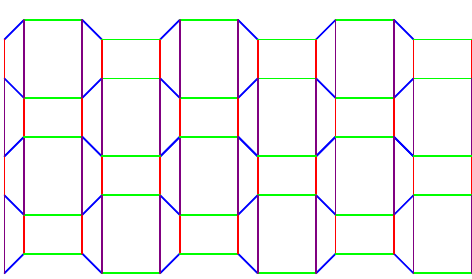
Fig. 28: All quadrilaterals are rectangles. Fig. 29: The vertex corona consists of two rect- angles and two equal trapezoids.